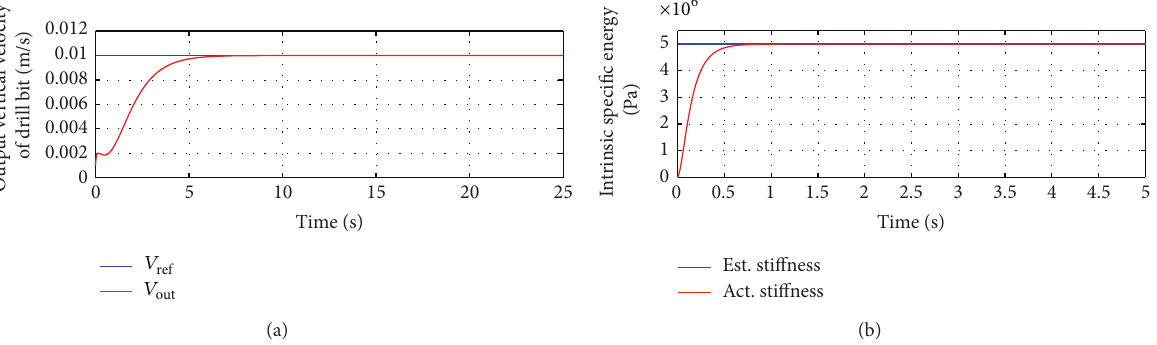
Figure 8: Response of rotational velocity 𝜔 1 (𝑡) (a), torque-on-bit 𝑇(𝑡) versus estimated torque-on-bit for 𝑊 0 = 2500 N, 𝜖 = 20 MPa, and 𝛾 0 = 5 ⋅ 10 9 .